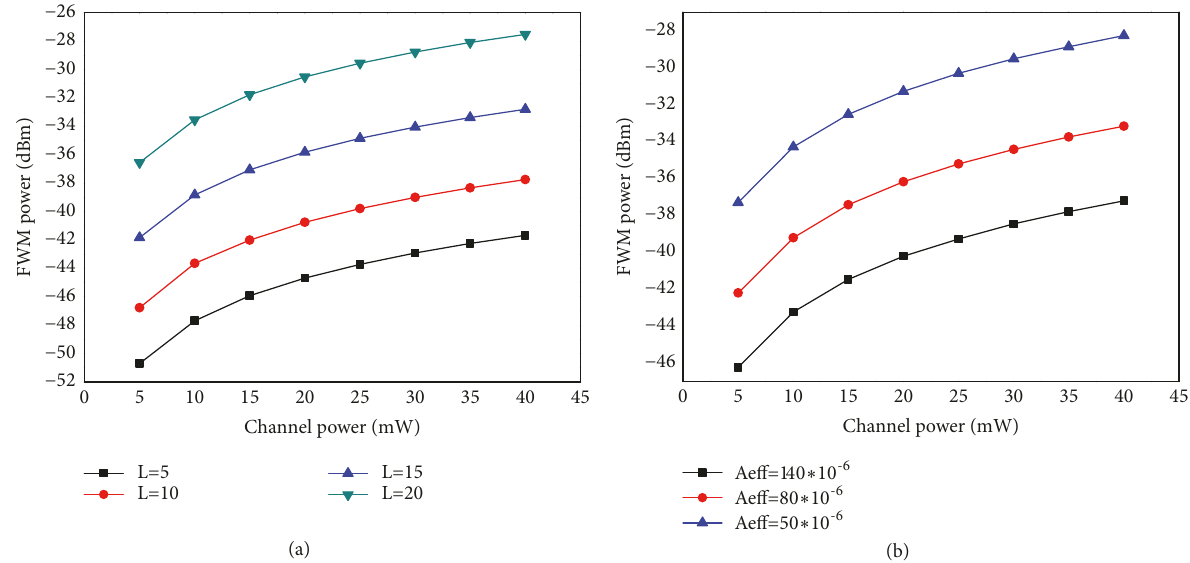
Figure 1: Dependence of FWM crosstalk products over channel power at different values: (a) fiber length (L) and (b) core effective area ( 𝐴 𝑒𝑓𝑓 ).